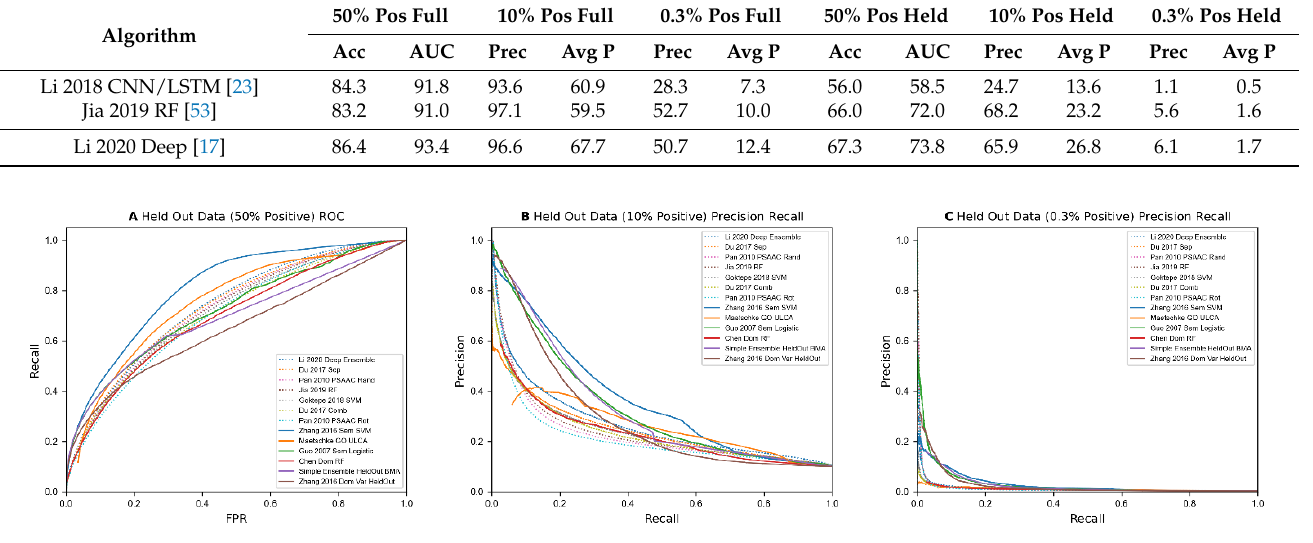
Figure 3. ( A ). ROC curve for results on held out proteins on 50% positive data, comparing sequence (dotted lines) an annoation-based methods (solid lines). ( B , C ). Precision Recall Curves for held out proteins on 10% and 0.3% positive data, comparing sequence and non-sequence-based methods. Non-sequence-based methods (solid lines) perform better at lower recall levels when positive data is more rare than random